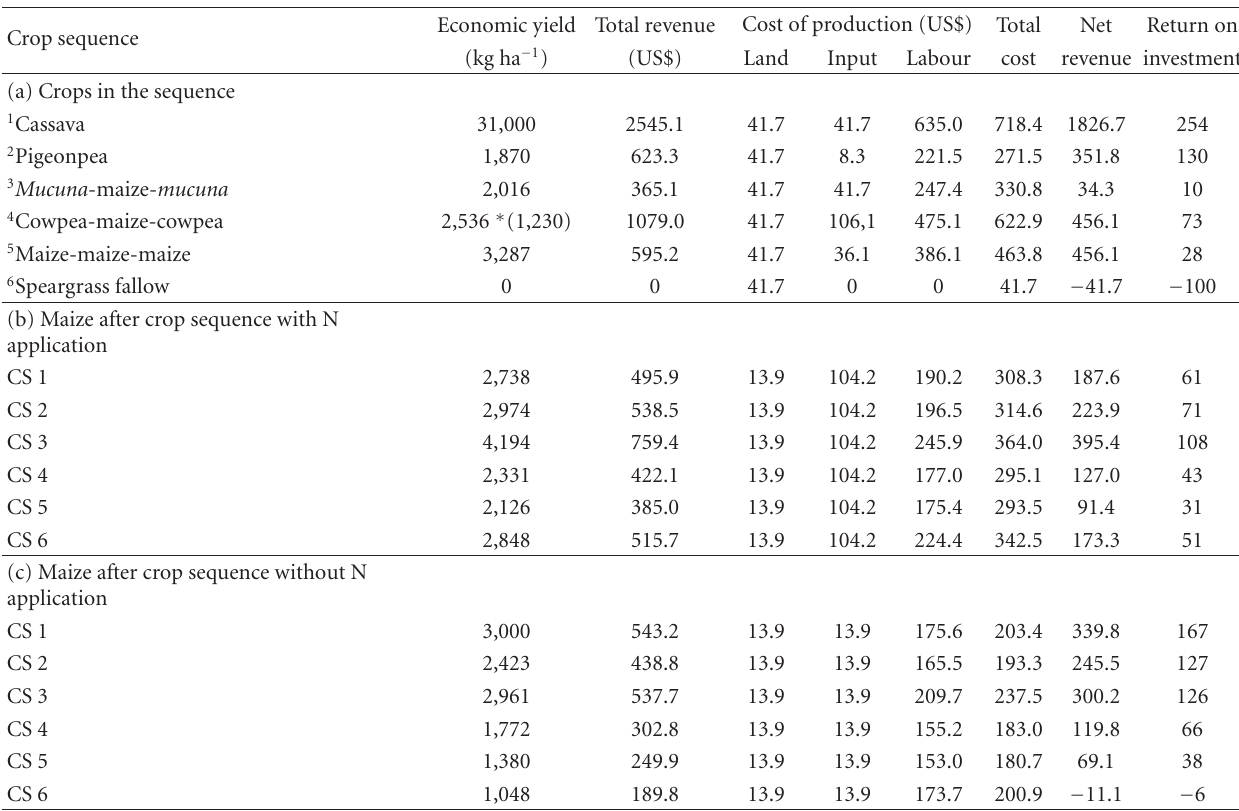
Table 4: Estimated costs of production, gross revenue and returns on investment of (a) various crop sequences (b) maize grown after the sequences with N application to the maize and (c) maize grown after the sequences without N application to the